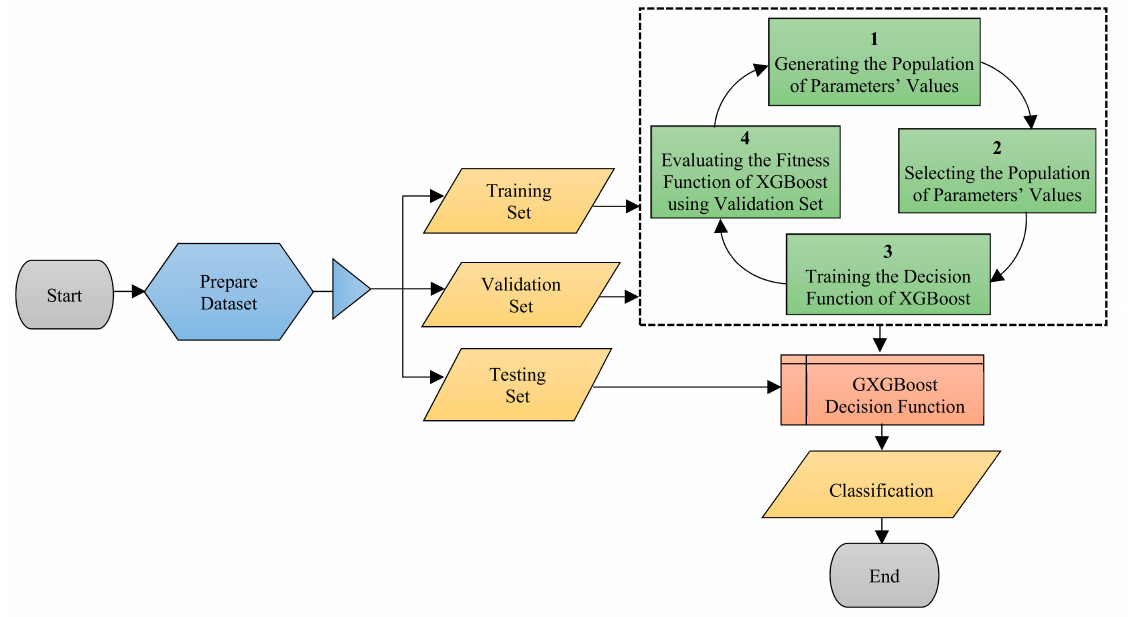
Figure 1. Flowchart of proposed genetic-based extreme gradient boosting (GXGBoot) Model. Algorithm 3. Pseudocode of GXGBoot’s steps